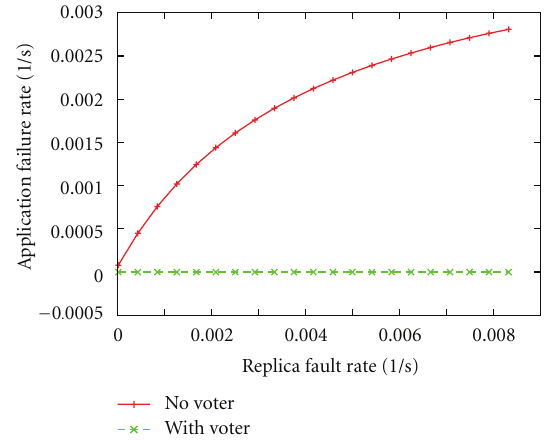
Figure 6: Application failure rate (fail/sec.) versus the replica fault rate under one